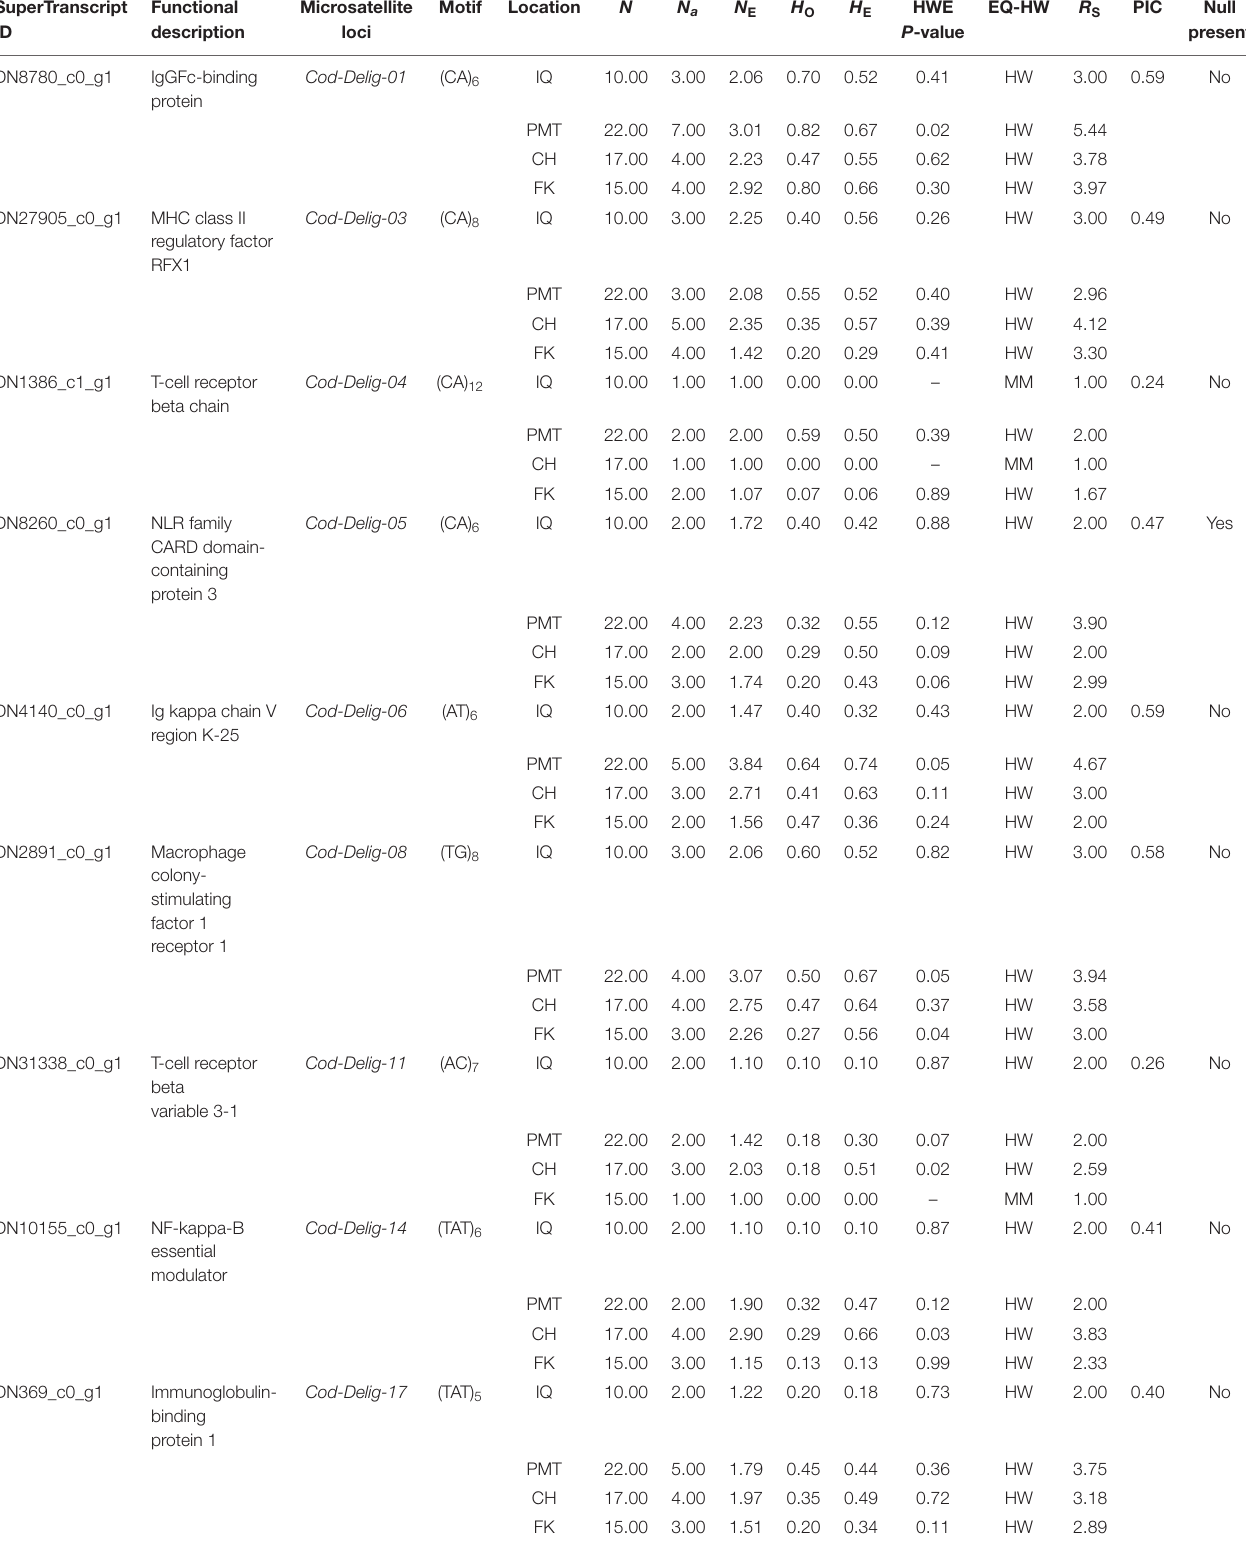
TABLE 4 | Characteristics of EST-SSR markers primers designed for Patagonian toothfish. SuperTranscript